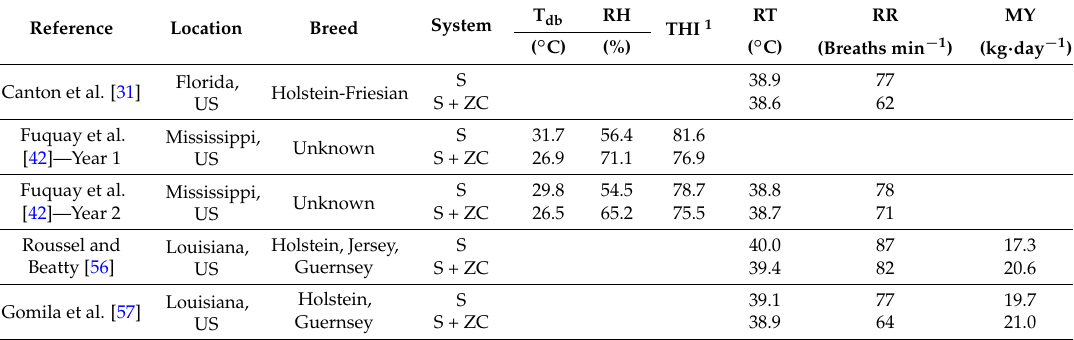
Abbreviations: T db = dry-bulb temperature, RH = relative humidity, THI = temperature-humidity index, RT = rectal temperature, RR = respiration rate, MY = milk yield; 1 Calculated from Schüller et al. [44]: THI = (1.8T db + 32) −